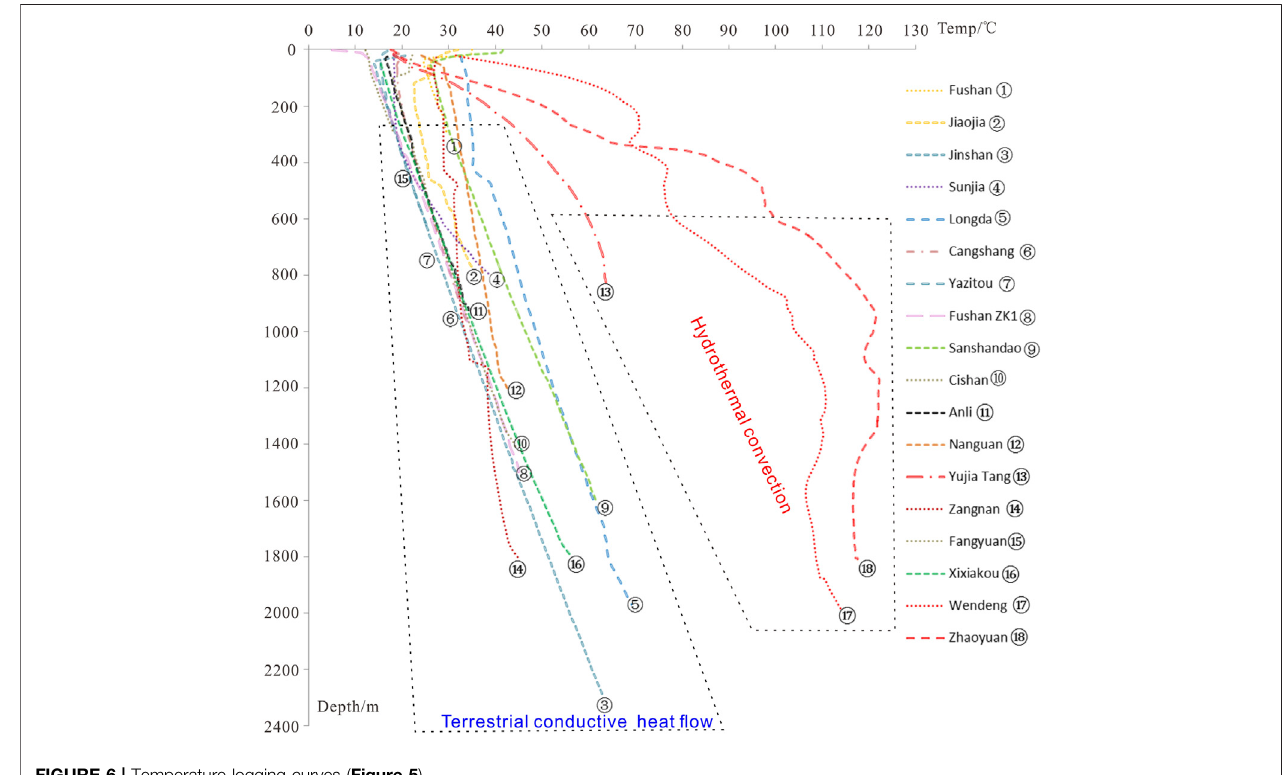
FIGURE 6 | Temperature logging curves ( Figure 5 ).